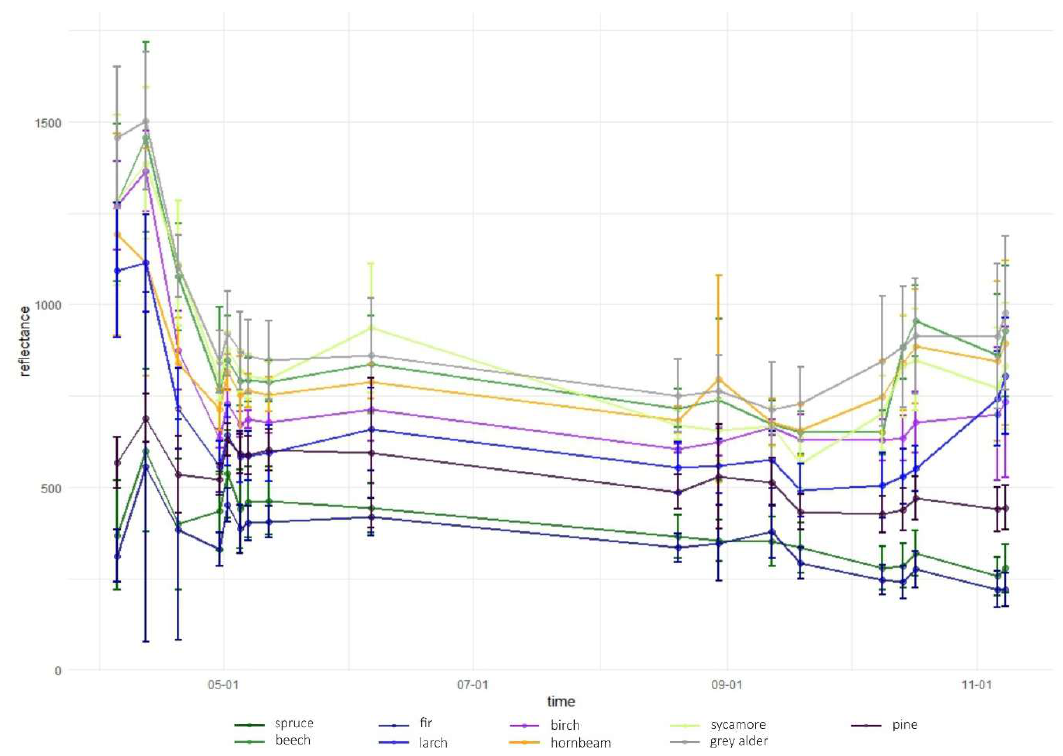
Figure A10. Mean and standard deviation values of reflectance in the short-waved 2 infrared band.